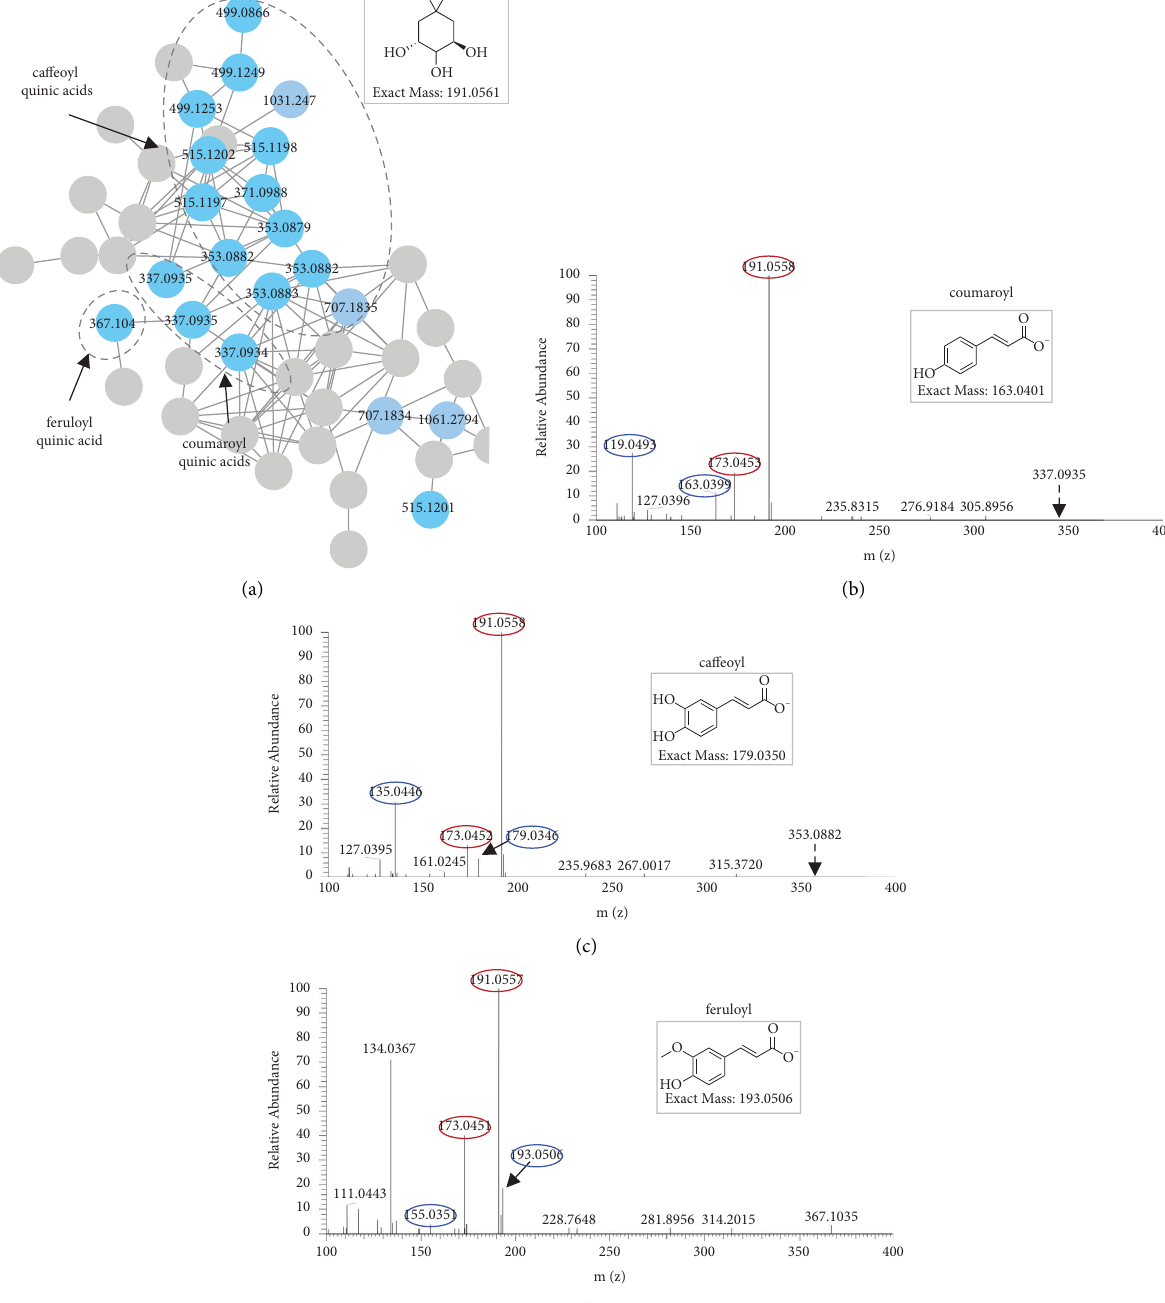
Figure 6: Molecular networking of quinic acid derivatives (a) and MS/MS spectra of coumaroyl quinic acid (b), chlorogenic acid (c), and 3- O-feruloylquinic acid (d) in LCP. Te nodes flled with bright blue and grey blue represent [M − H] − and adduct ions of compounds, respectively. Te chemical structure nodes flled with grey colour are not annotated in present